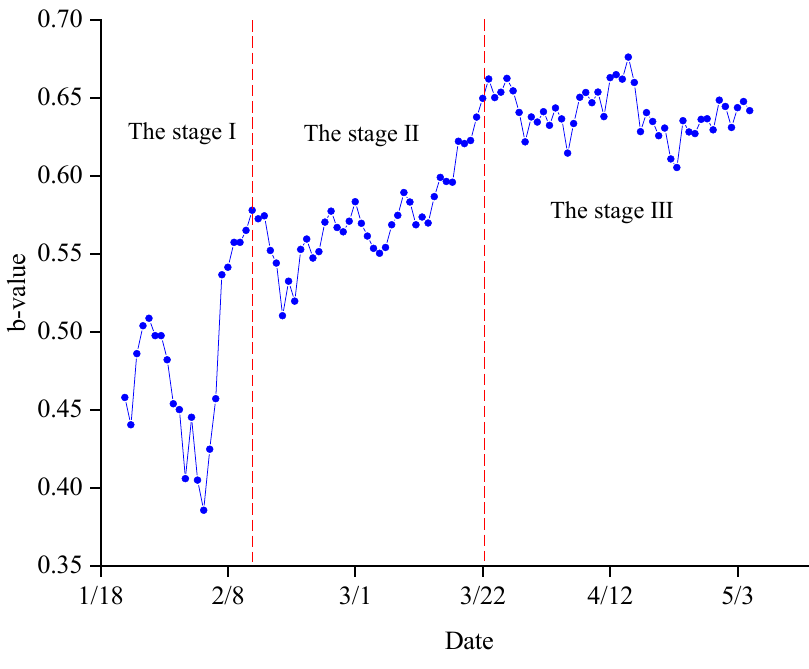
b value. Figure 16. Change of b